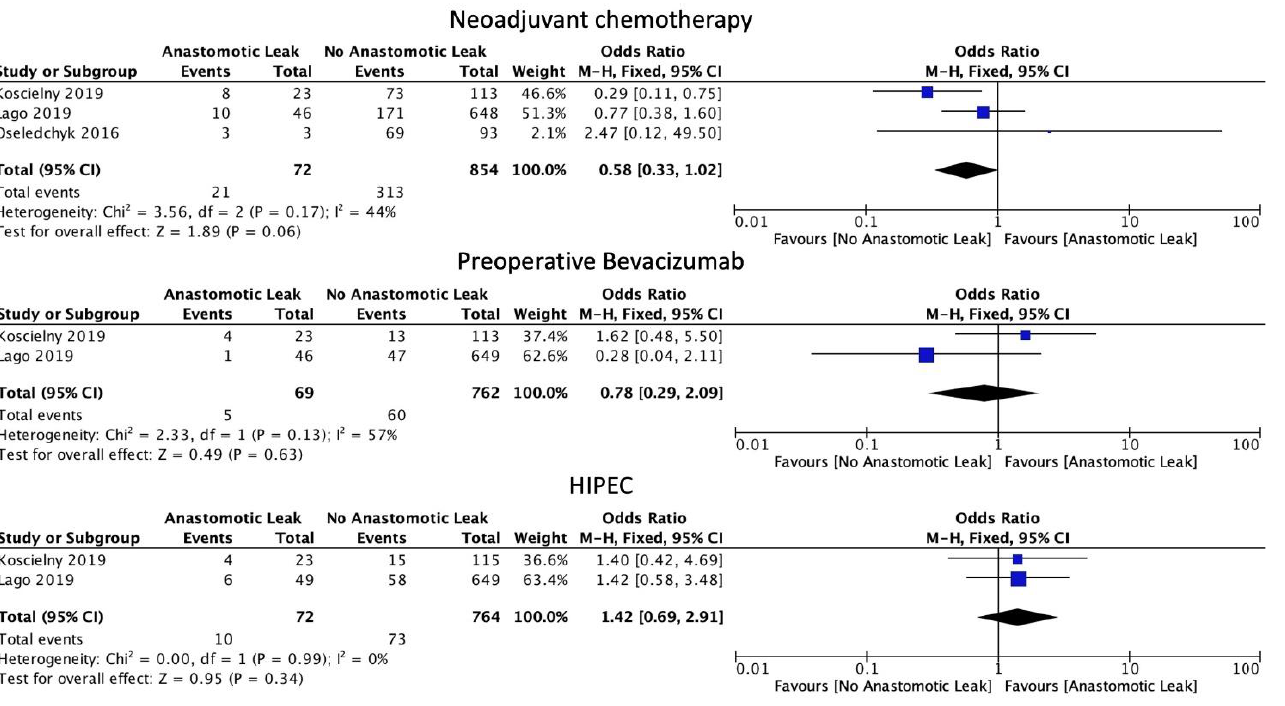
(Figure 5). Protective stoma (OR: 0.82, 95% CI: 0.51 to 1.30, p = 0.39, I2 = 69%) as well as primary (OR: 1.72, 95% CI: 0.94 to 3.15, p = 0.08, I2 = 22%) versus secondary